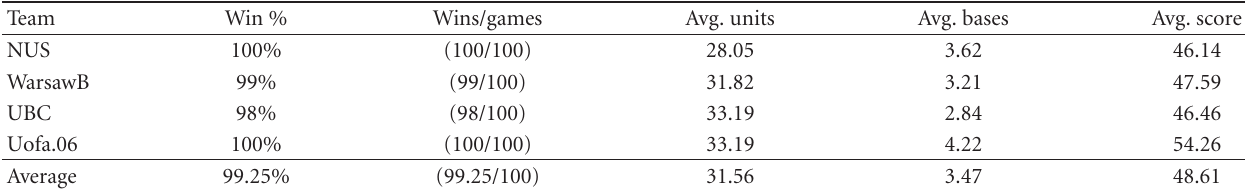
Table 6: Experiment results from using maximum potential, instead of summing the potentials.